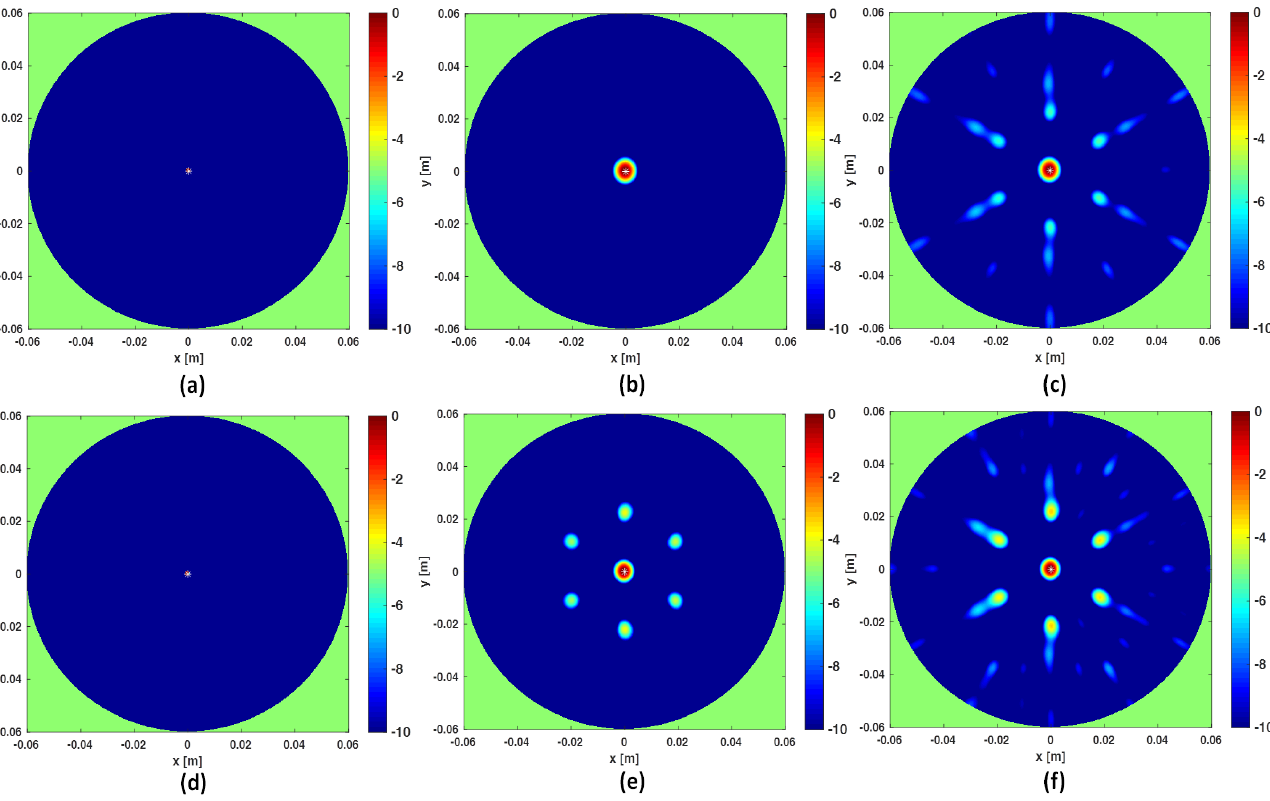
Figure 3. Illustrating the role of the frequency band. In all the reconstructions only N o = 7 sensors are considered. In the top panels the frequency band is [ 1,3 ] GHz, in the bottom panels the frequency band is reduced to [ 2,3 ] GHz. Finally, ( a , d ) refer to I-MUSIC, ( b , e ) to BF and ( c , f ) to